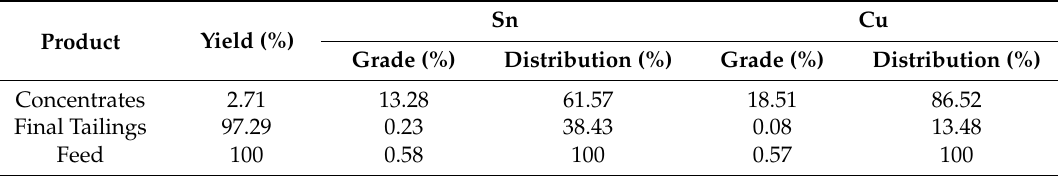
Table 4. Results of the bench-scale closed circuit flotation experiments of shaking table tailings.